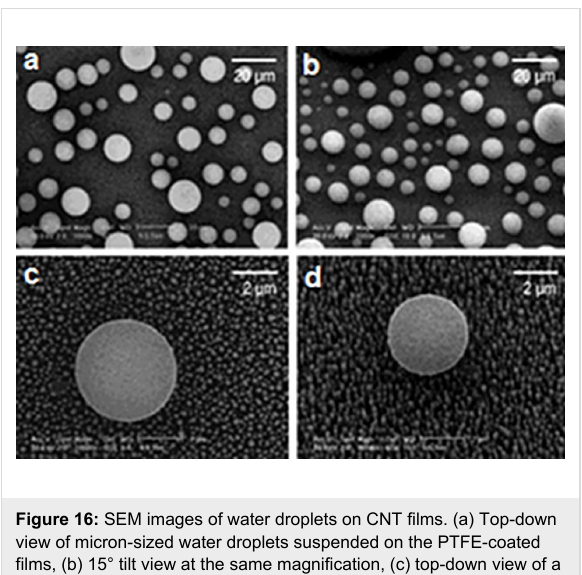
Figure 16: SEM images of water droplets on CNT films. (a) Top-down view of micron-sized water droplets suspended on the PTFE-coated films, (b) 15° tilt view at the same magnification, (c) top-down view of a single suspended water droplet in which the PTFE-coated nanotubes are also visible, and (d) 15° tilt view at the same magnification. Adapted with permission from [131]. Copyright 2003 American Chem- ical Society.